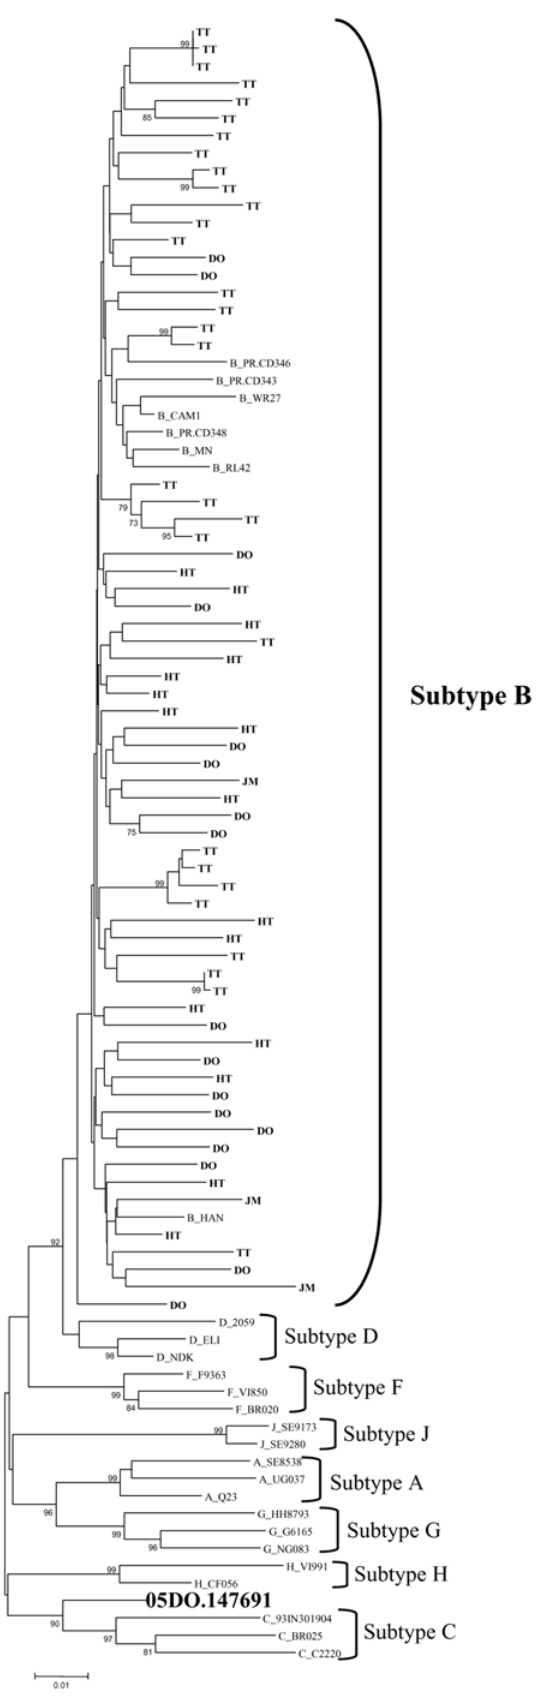
Figure 1. Phylogenetic analysis of 67 partial pol sequences of HIV-1 from Caribbean countries: Trinidad and Tobago (TT), Dominican Republic (DO), Haiti (HT) and Jamaica (JM). A neighbor-joining phylogenetic tree was built using the Kimura 2- parameter model and significant parsimony bootstrap values ( . 70%) were placed next to the nodes. The genetic distance corresponding to the lengths of the branches is shown by the scale below the tree. Reference samples are those named, preceded by the subtype; one of the study samples (the B/C recombinant) is also named.